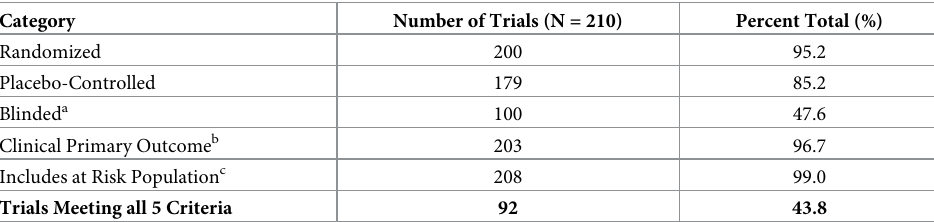
Table 2. Evaluation of design quality of trials meant to inform clinical practice. Category Number of Trials (N = 210) Percent Total (%) Randomized 200 95.2 Placebo-Controlled 179 85.2 Blinded a 100 47.6 Clinical Primary Outcome b 203 96.7 Includes at Risk Population c 208 99.0 Trials Meeting all 5 Criteria 92